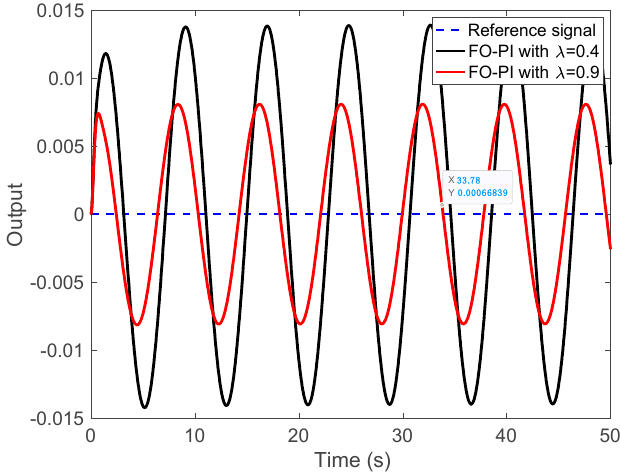
Figure 4. Disturbance rejection results for two different FO-PI controllers for a 0.8 rad/s disturbance frequency.